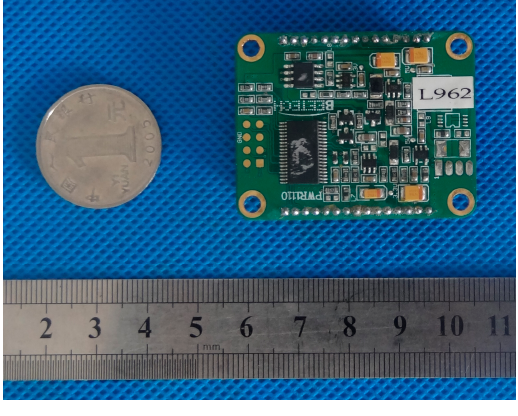
Figure 10. Power module.